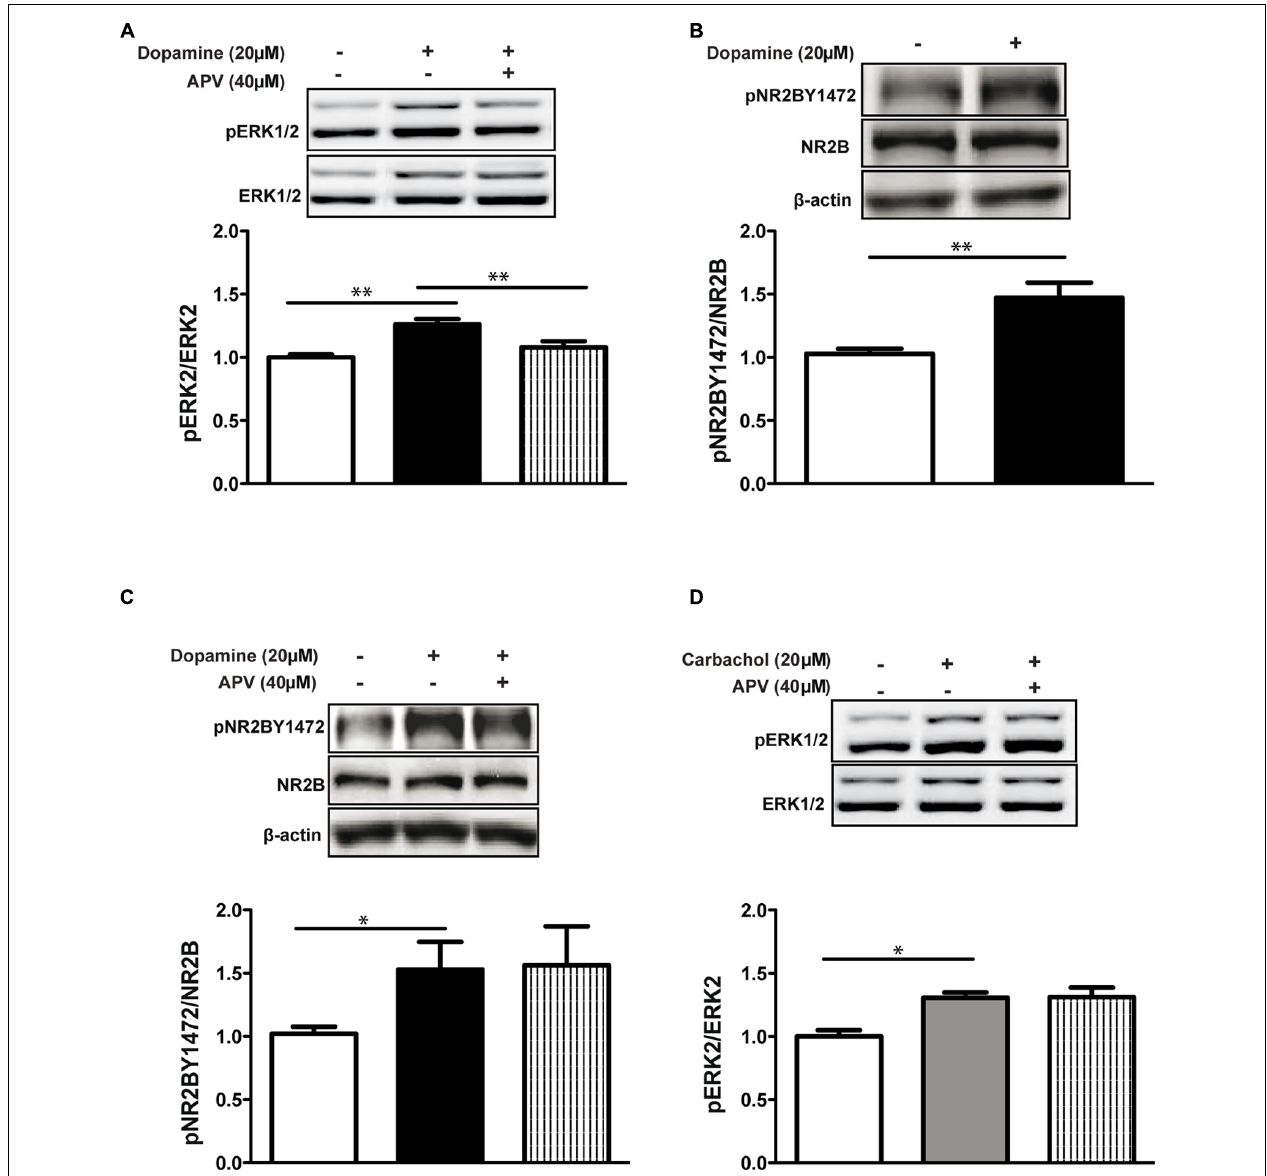
phosphorylation (** p < 0.01, n = 24). (C) APV (40 μ M) does not affect NR2B Y1472 phosphorylation (* p < 0.05, n = 12). (D) Carbachol (20 μ M, 10 min) increases ERK1/2 activation (* p < 0.05, n = 12) independently of the NMDA receptor. Data are means ± SEM.